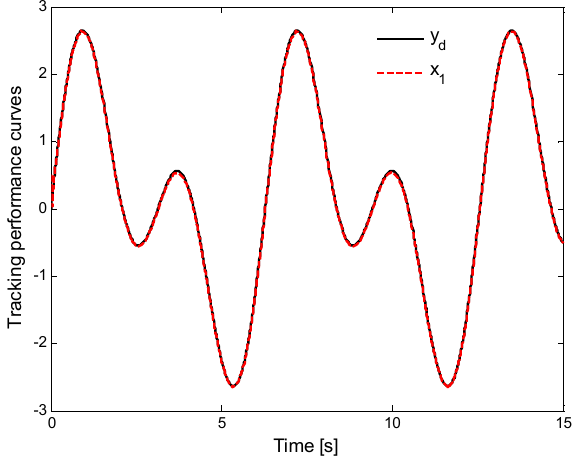
Figure 8. Trajectories of system output x 1 ( t ) and desired signal y d .